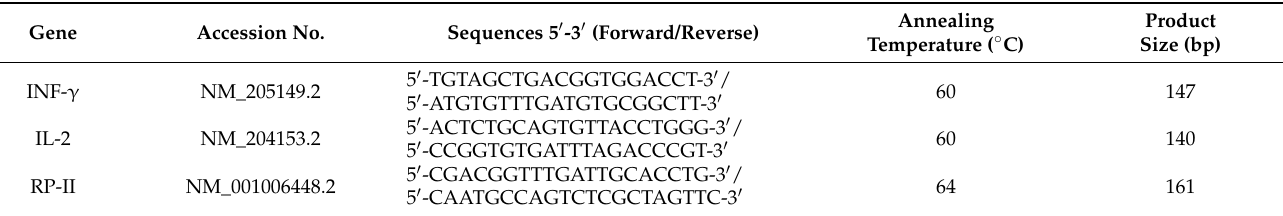
Table 2. Primers used for real-time